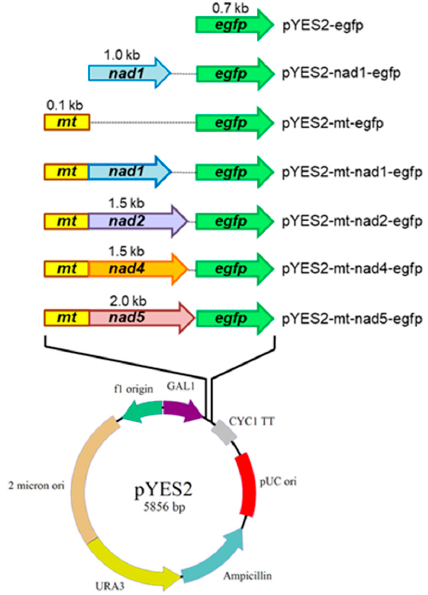
Figure 4. Schematic diagram of the constructed plasmids transformed into S. cerevisiae . The mitochondrion-encoded nad1 , nad2 , nad4 , and nad5 cDNAs were inserted into the pYES2-mt-egfp plasmid. mt : mitochondrial targeting gene; egfp : enhanced green fluorescent protein gene; GAL1: yeast GAL1 promoter; CYC1 TT: transcription terminator; pUC ori: E. coli replication origin bases; ampicillin: ampicillin resistance gene; URA3: orotidine 5-phosphate decarboxylase gene; 2 micron ori: maintenance and high-copy replication origin in yeast; f1 origin: F1 phage origin.